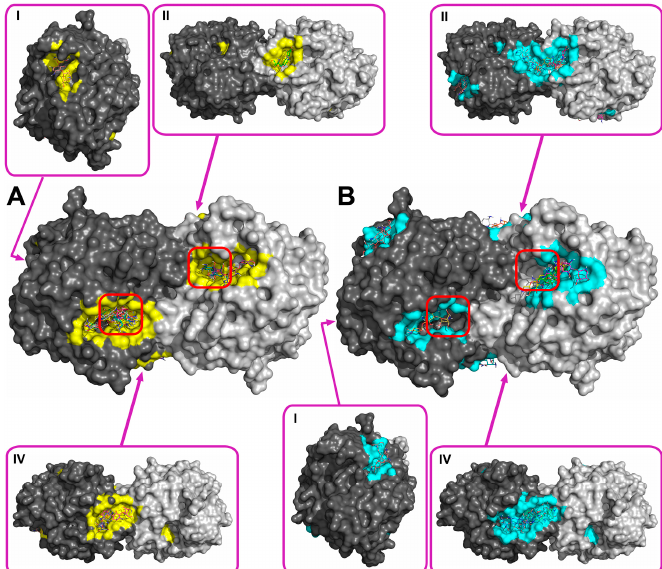
Figure 4. Supposed localization of the domains for binding kanamycin at pH 7.5 ( A ) and 10.5 ( B ). The two subunits of the His 6 ‐ OPH homodimer are colored differently (grey and dark grey). Atoms on the surface of His 6 ‐ OPH located within 4 Å of any atom of kanamycin, as well as the corresponding molecular surface, are colored yellow ( A ) or cyan ( B ), respectively. Entrances to the active sites of the His 6 ‐ OPH dimer are highlighted with red boxes. Magenta boxes show clockwise a His 6 ‐ OPH dimer molecule when it is viewed from the left (I), from above (II), and from below (IV) (relative to the side where the active sites are located).